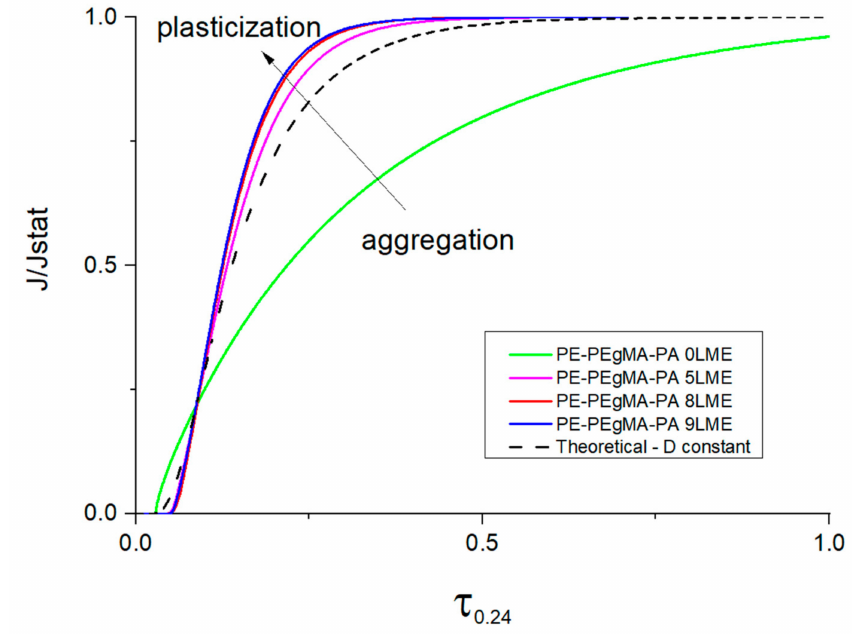
Figure 9. Reduced water flux through PE/PEgMA/PA6 multilayer